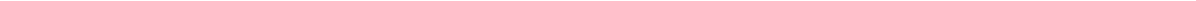
Fig. 1 Functional screen identi fi es miR-584-5p as a new therapeutic adjuvant in MB. a Outline of the primary screen and list of drug-sensitizer, drug- desensitizer, and drug-neutral miRNAs. A total of 1902 miRNA mimics arrayed in 96-well plates were screened in triplicates. b Line graphs showing relative viability of DAOY cells transfected with miR-NC or indicated VCR-sensitizer miRNAs ( miR-584-5p , miR-1266, miR-126-5p, miR-335-5p, miR-9-5p, miR-449b ; obtained from primary screen) for 24 h followed by treatment with vehicle or increasing concentration of VCR for 72 h. Cell viability was assessed using alamarBlue ® cell viability assay. p -value was calculated using one-way ANOVA followed by Dunnett ’ s multiple-comparisons test. Error bars represent the mean ± SEM of three independent experiments (performed in sixtuplicate for each experiment). c – g Dose – response curves showing VCR sensitivity in miRNA negative control (NC) (blue line) and miR-584-5p mimic-transfected D556Med, D458Med, D425Med, DAOY, and primary MB BT-28 cells. MB cells were transfected with miR-NC or miR-584 mimic followed by treatment with VCR or vehicle for 72 h. Cell viability was assessed using alamarBlue cell viability assay. The p -values were determined by the sum-of-squares F test. Error bars represent mean ± standard error of the mean (SEM) of three independent experiments (performed in sixtuplicate for each experiment). h Synergistic effect of miR-584-5p with VCR. D556Med cells were treated with increasing concentrations of miR-584-5p and VCR before being subjected to cell viability assay using alamarBlue cell viability assay. Compusyn software (http://www.combosyn.com/) was used to calculate combination indices (CIs). The p -values were determined by the sum-of-squares F test. Error bars represent mean ± SEM of three independent experiments (performed in sixtuplicate for each